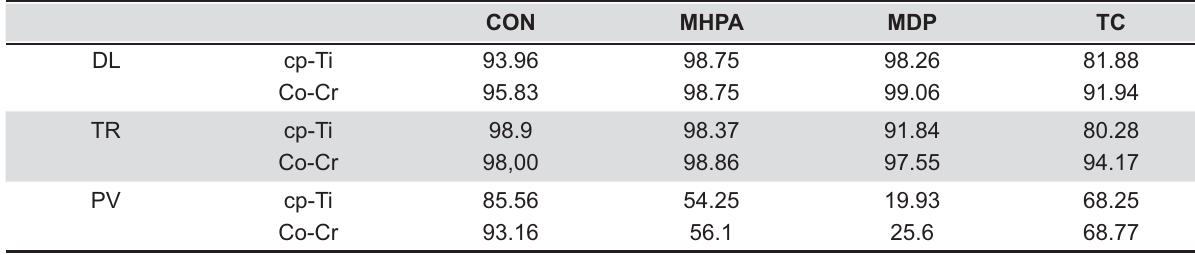
Table 2- Decrease rates of bond strength with thermocycling